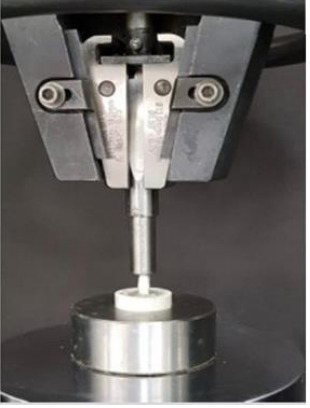
Figure 2. Fracture resistance test using Universal Testing Machine.